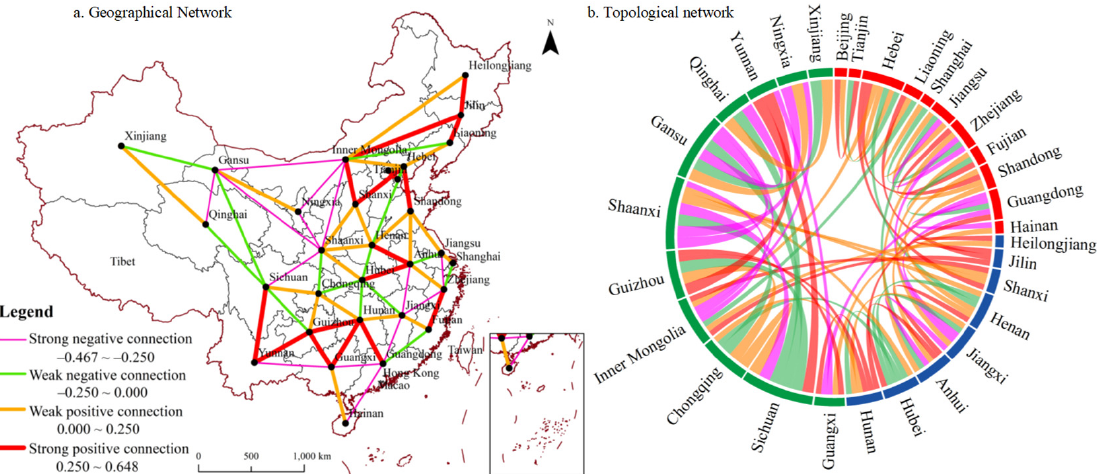
Figure 3. Spatiotemporal network of rural energy poverty interaction among provinces in China. ( a ) Geographical network; ( b ) topological network.